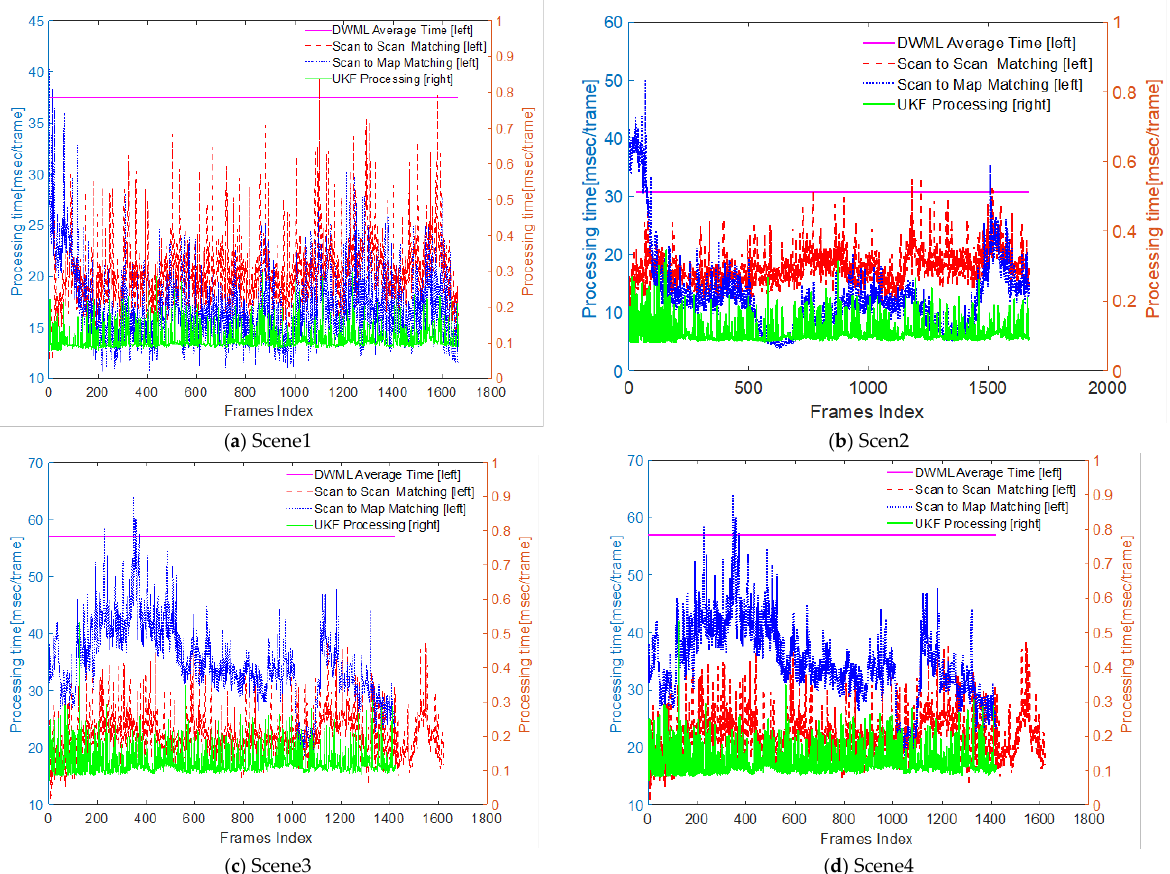
Figure 15. Localization time of the four underground roadway scenes. Table 1. Process time of each module in Scene 1 and Scene 3.